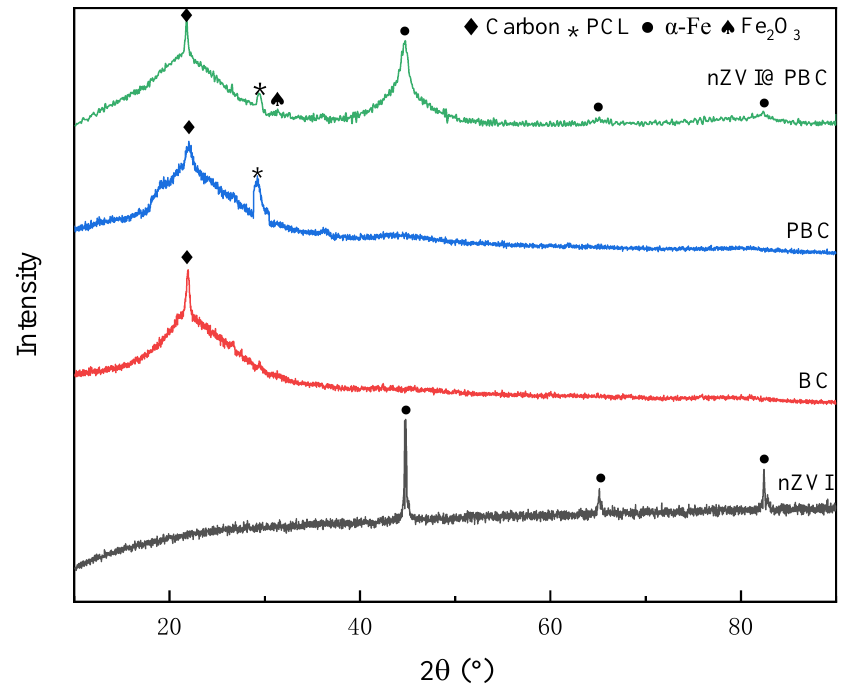
Figure 3. XRD patterns of nZVI, BC, PBC and nZVI@PBC.